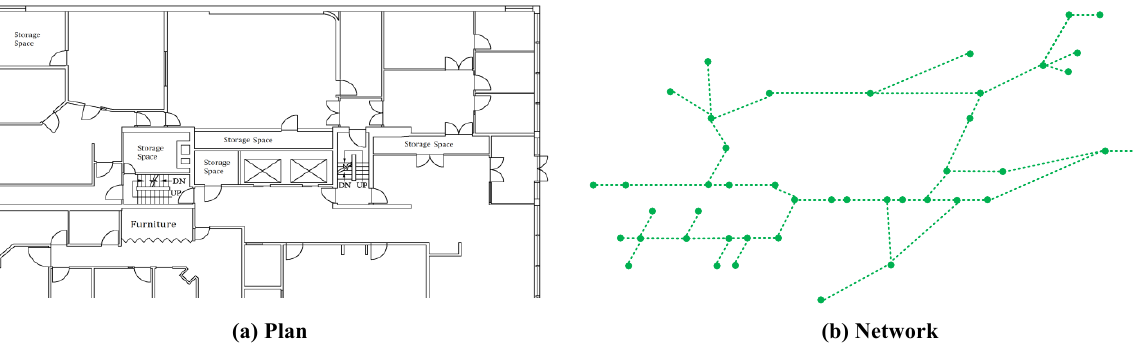
Figure 4. Plan of the first floor of a building and the corresponding accessible network for